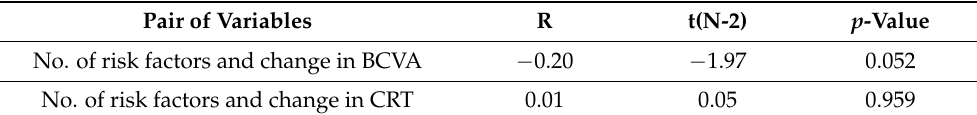
Table 6. Number of risk factors and changes in BCVA and CRT at 12 months (Spearman’s rank